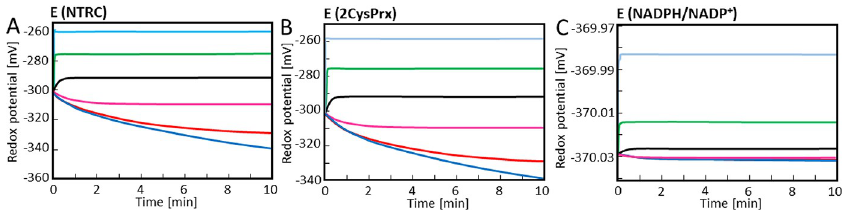
Fig 4. Time-dependent simulation of the redox potentials of the FNR-network components. The redox potentials were simulated for the FNR-network components FdX, FNR, NADPH, NTRC and 2CysPRX in dependence of the clamped H 2 O 2 concentration. Redox potentials were calculated at each time step using Nernst equation for (A) NTRC, (B) 2CysPRX and (C) NADPH/NADP + couple. The simulation was run for 10 minutes at constant H 2 O 2 concentration of 0 μ M (blue), 1 nM (red), 10 nM (magenta), 100 nM (black), 1 μ M (green) and 10 μ M